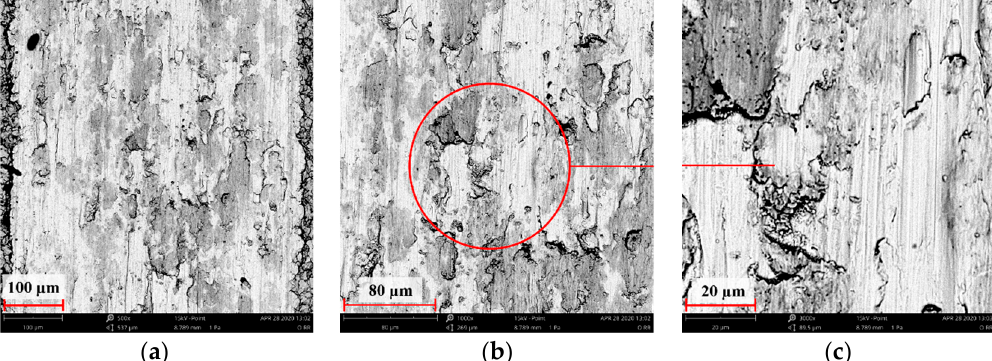
Figure 25. SEM image of the oxygen ion-implanted steel 316L wear track after friction with RS lubrication: ( a ) ×500, ( b ) ×1000, ( c ) ×3000.